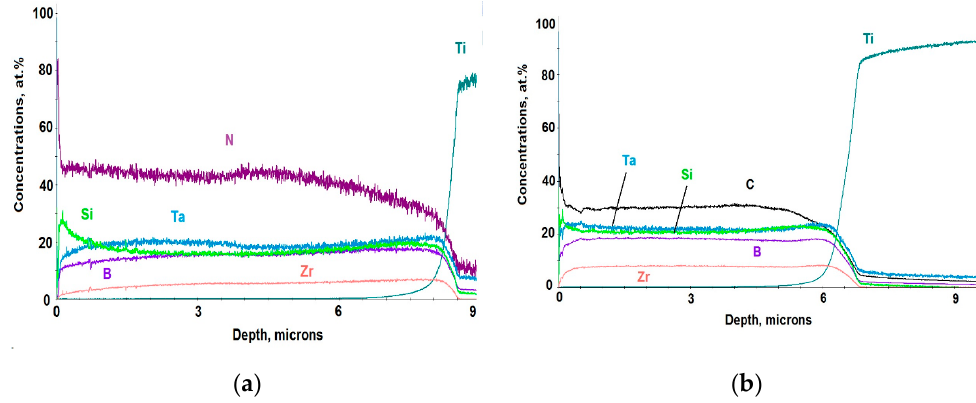
Figure 1. Typical glow discharge optical emission spectroscopy (GDOES) profiles of coatings 3 (10 sccm N 2 ) ( a ) and 5 (10 sccm C 2 H 4 ) ( b ).